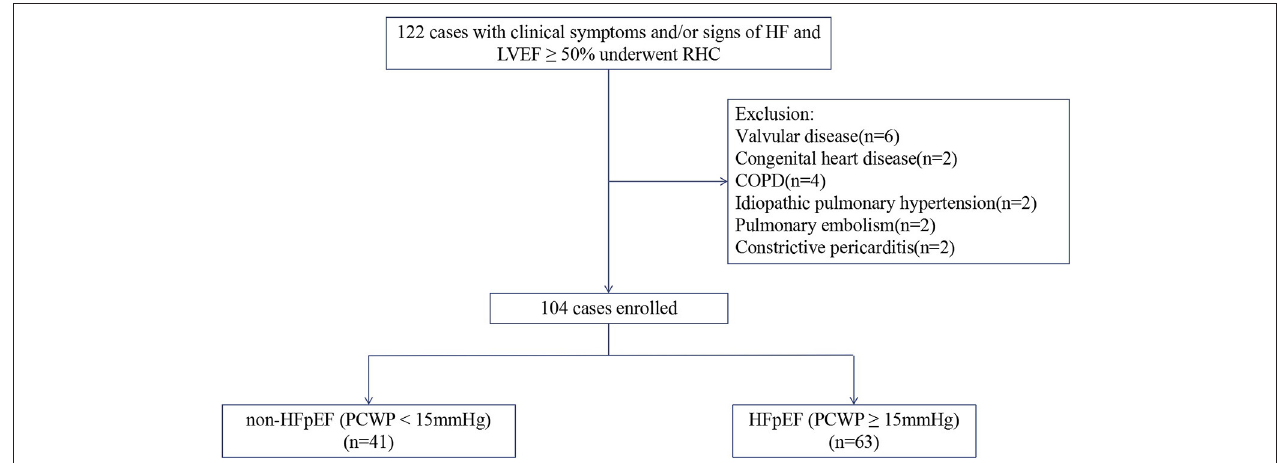
FIGURE 1 | Flowchart of study selection. HF, heart failure; LVEF, left ventricular ejection fraction; RHC, right heart catheterization; COPD, chronic obstructive pulmonary disease; HFpEF, Heart failure with preserved ejection fraction; PCWP, pulmonary capillary wedge